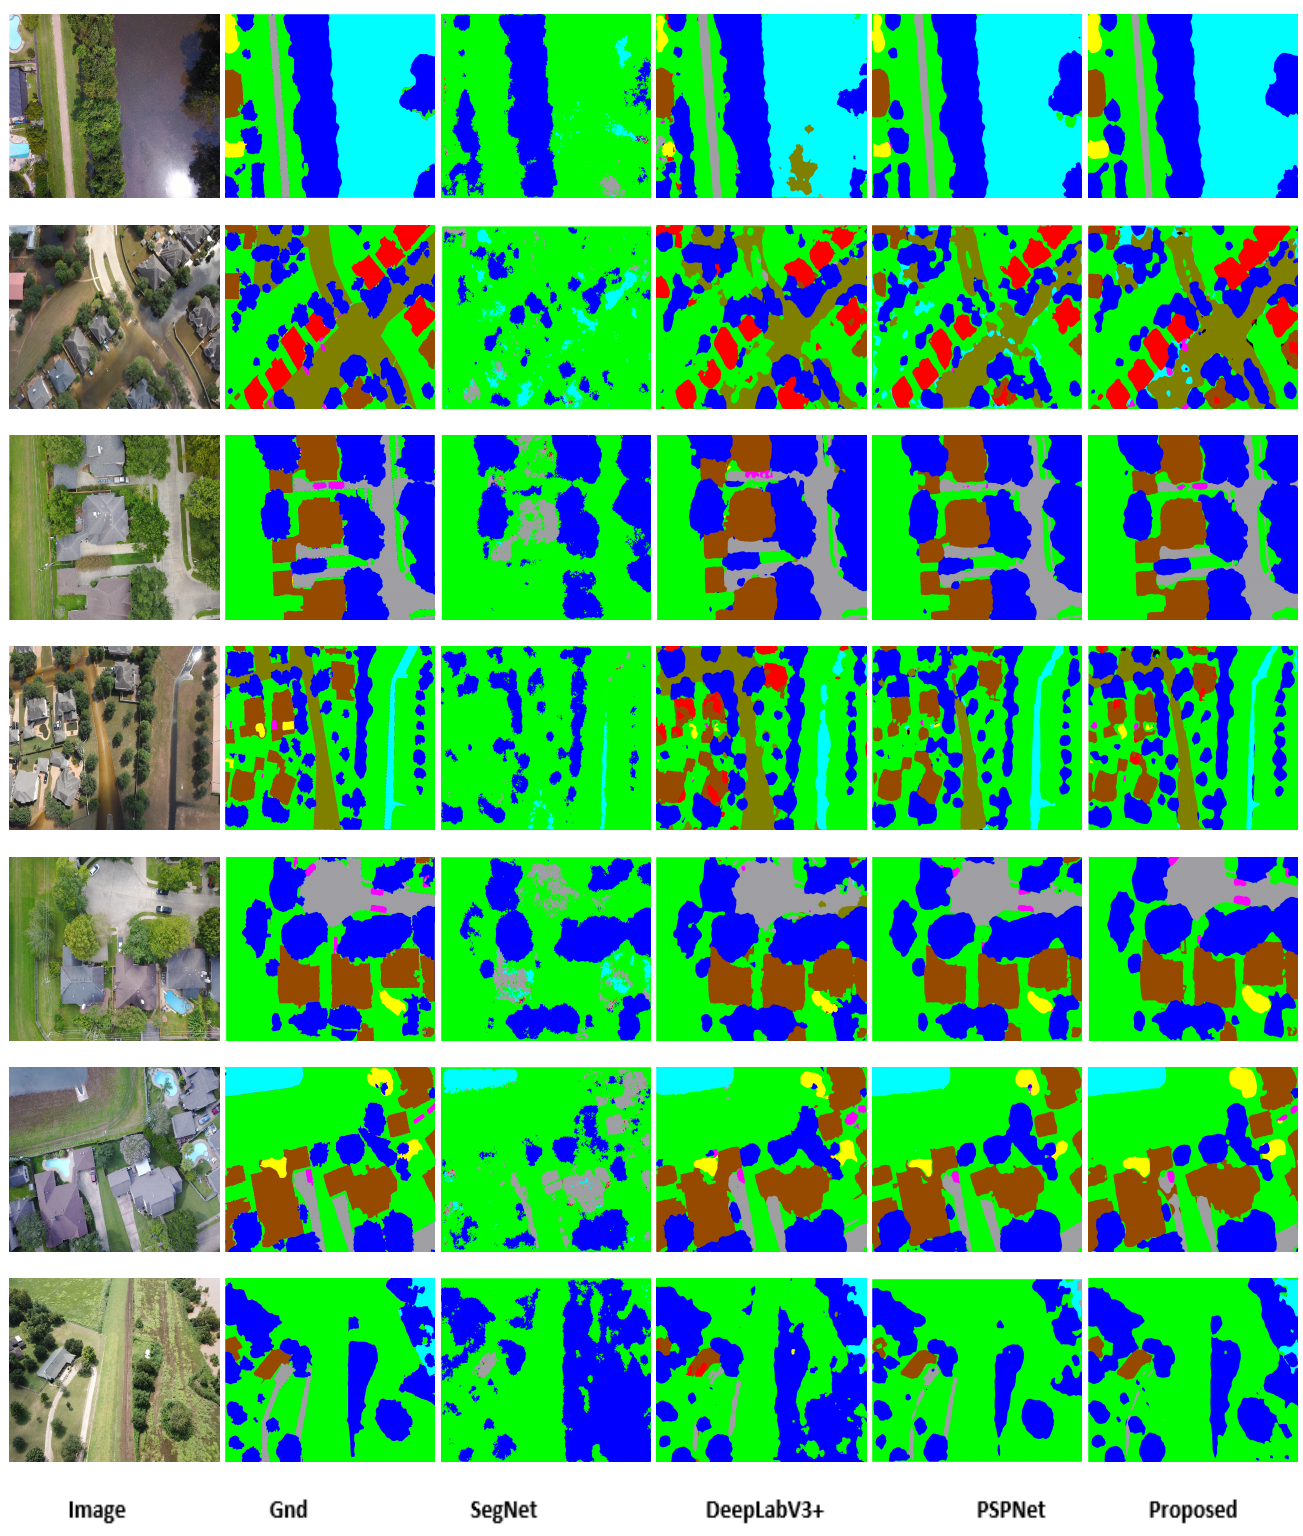
Figure 6. Qualitative comparison of different methods for flood